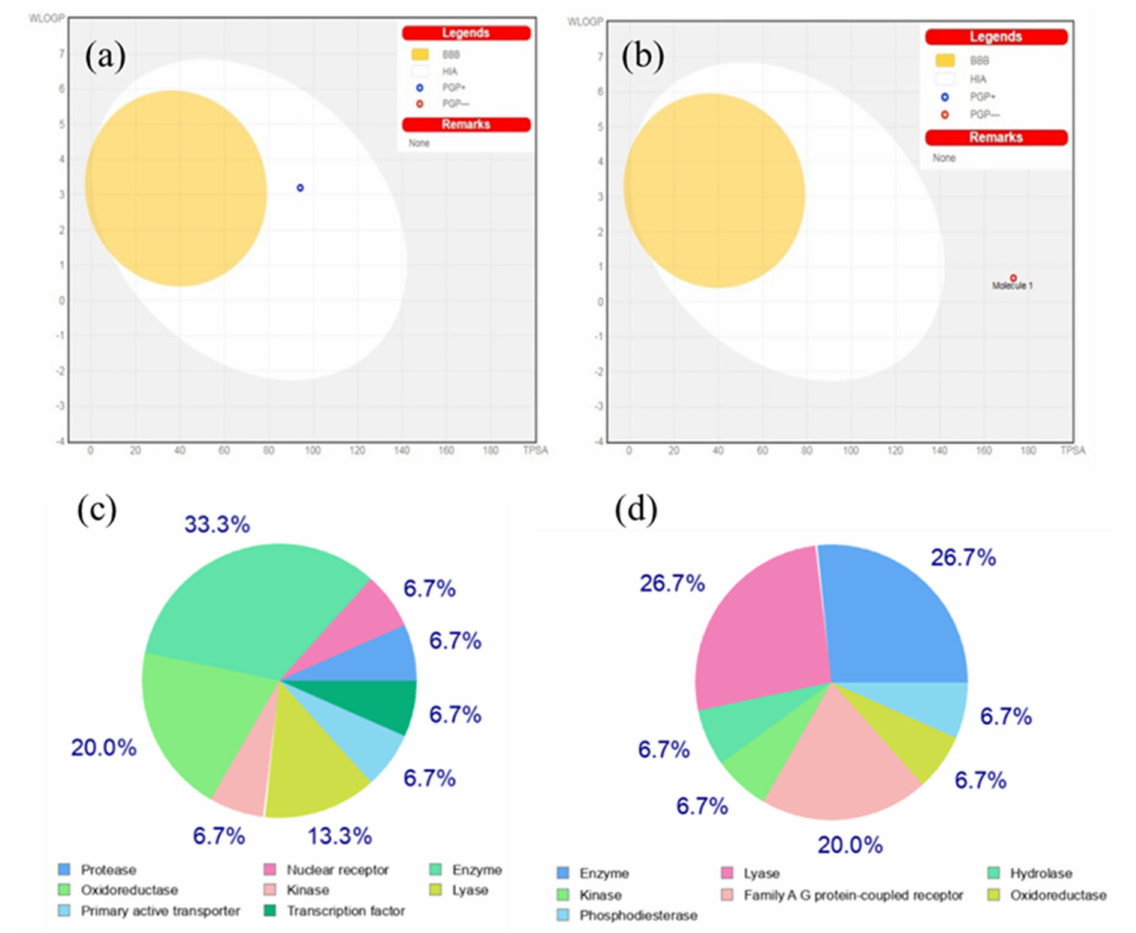
Figure 4. BOILED − egg graphs: ( a ) pelargonidin; and ( b ) pelargonidin − 3 − O − glucoside. Target prediction report: ( c ) pelargonidin; and ( d )